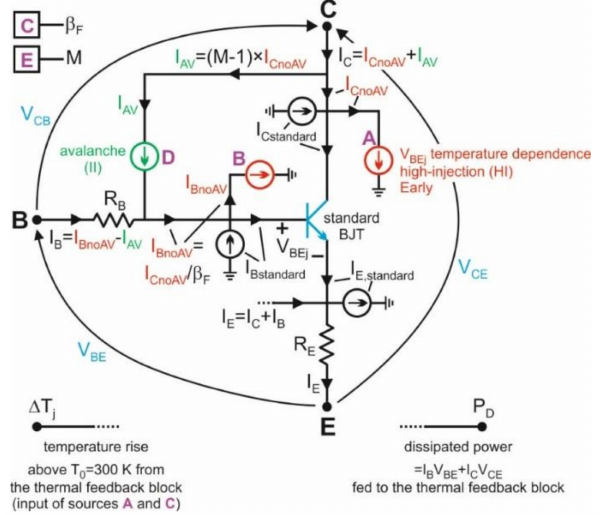
Figure 3. Simplified representation of the SPICE-compatible unit-cell subcircuit implementing the analytical model described in Section 3.2.